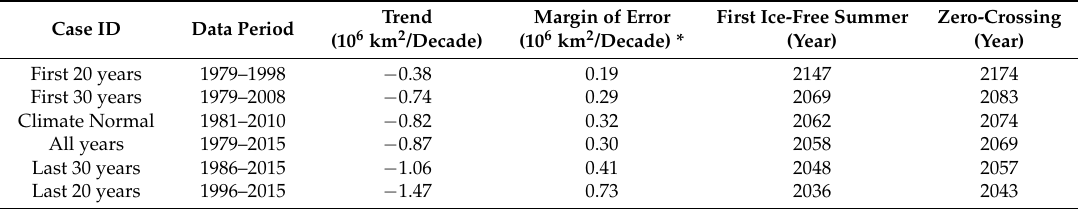
Table 2. Attributes of linear regressions and projected FIASY and zero-crossing